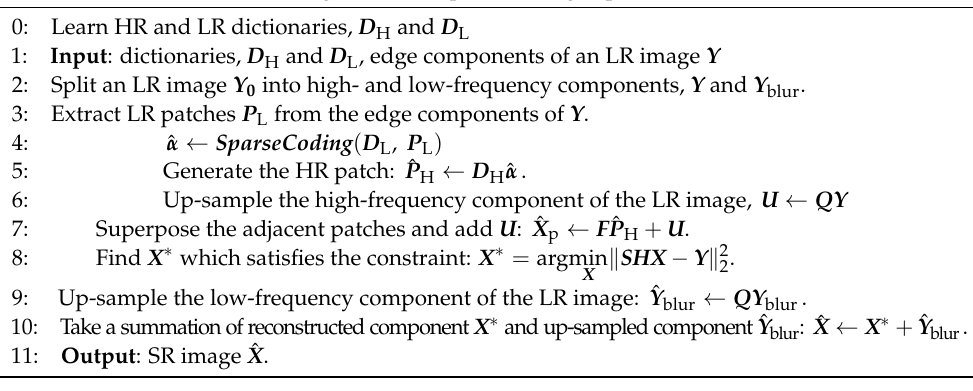
Algorithm 1 . Reconstruction algorithm for sparse coding super-resolution